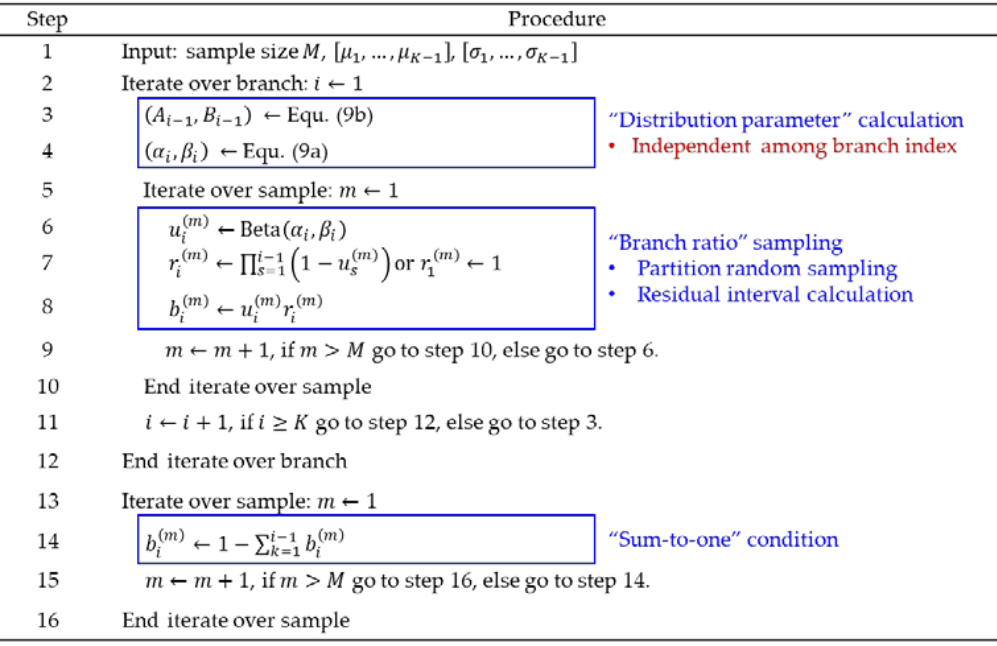
Figure 4. Sampling procedures in gDIR sampling method.